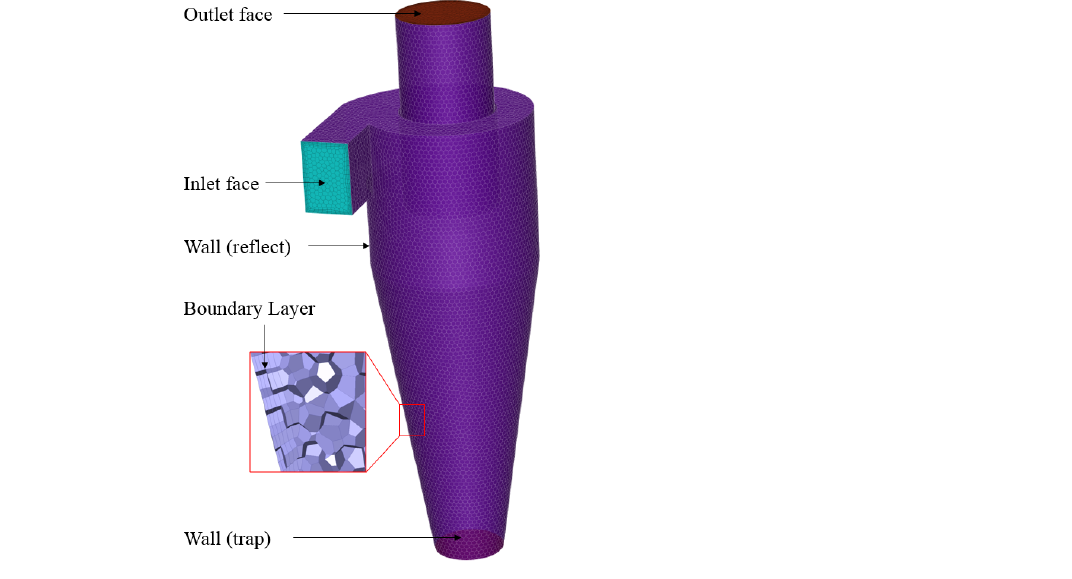
Figure 3. The shape and distribution of elements in the computational domain.